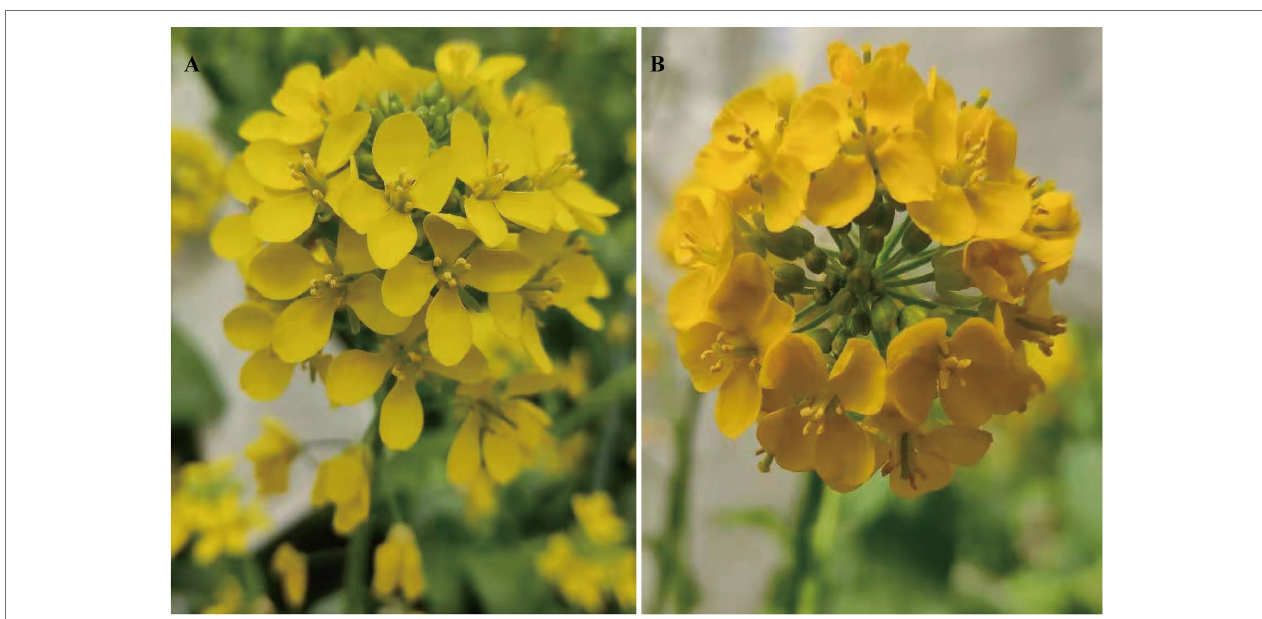
FIGURE 1 | Phenotypic characterization of flower color in the two parent lines (R16-11 and SD369). The flower color of R16-11 (A) is yellow at the flowering stage, while dark yellow for SD369 (B)